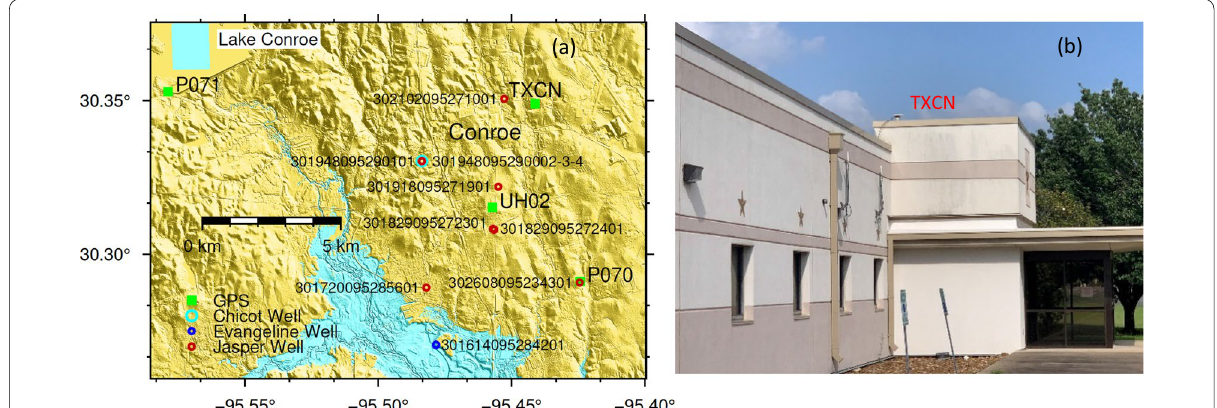
Fig. 14 a Map showing the locations of GPS stations and groundwater-level observation wells in the Conroe area; b GPS antenna TXCN, mounted on the roof of the Texas Department of Transportation office building in the City of Conroe, Montgomery County. The LiDAR data for plotting the DEM map is available at NOAA (https:// coast. noaa. gov/ datav